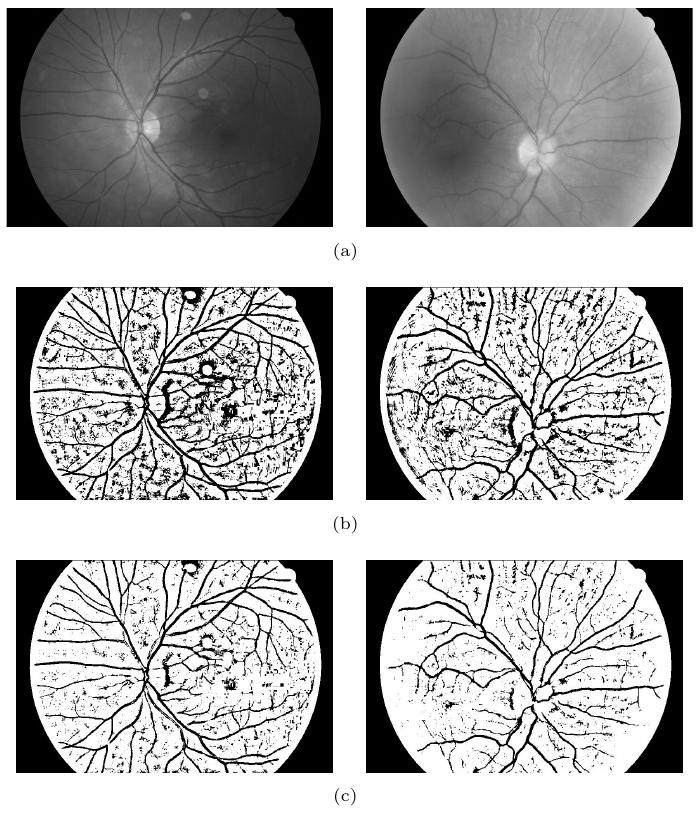
Figure 2. (a) Grey scale images, (b) binarization by the original Sauvola method, (c) binarization by the modified Sauvola